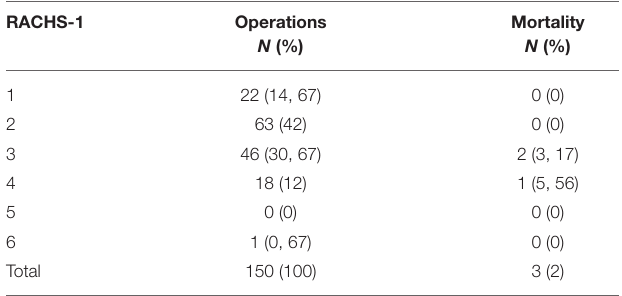
TABLE 5 | Distribution of the pediatric patients operated in 2020 by the complexity level and mortality, expressed in RACHS category classification. RACHS-1 Operations Mortality N (%) N